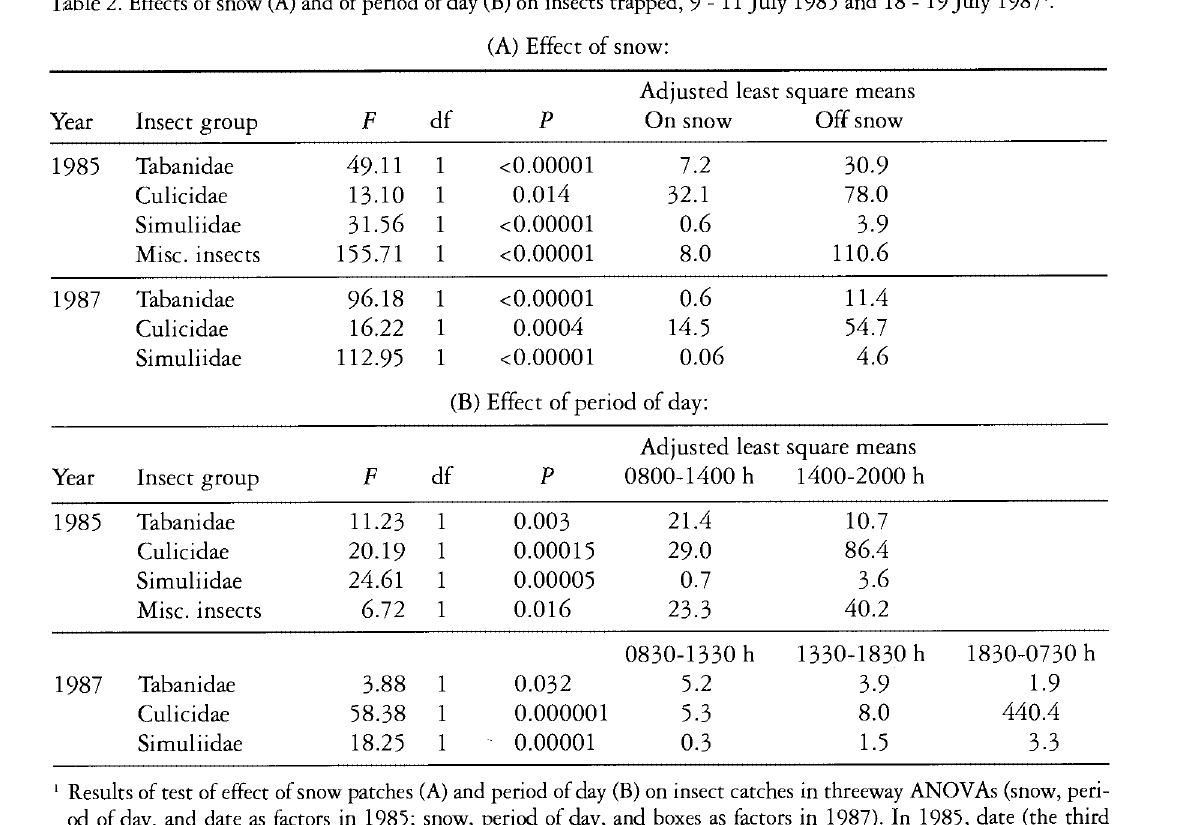
Table 2. Effects of snow (A) and of period of day (B) on insects trapped, 9 - 11 July 1985 and 18 - 19 July 1987 1 . (A) Effect of